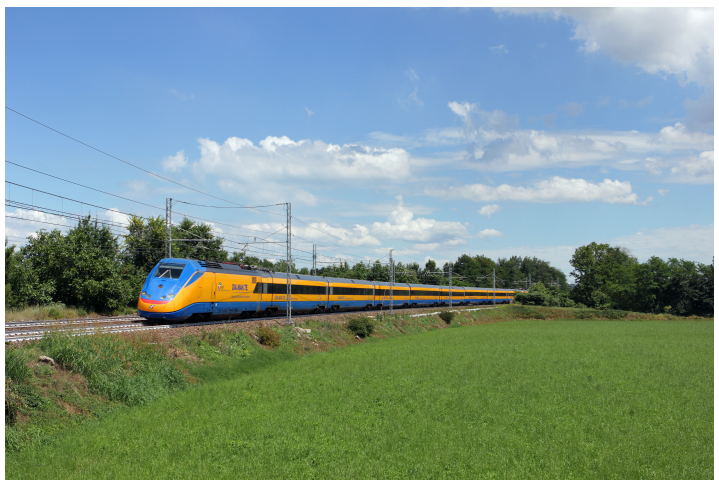
Figure 8. ETR.500 Y 2 “Dia.man.te”, high speed (300 km/h) visual inspection EMU (courtesy of c (cid:13) Stefano